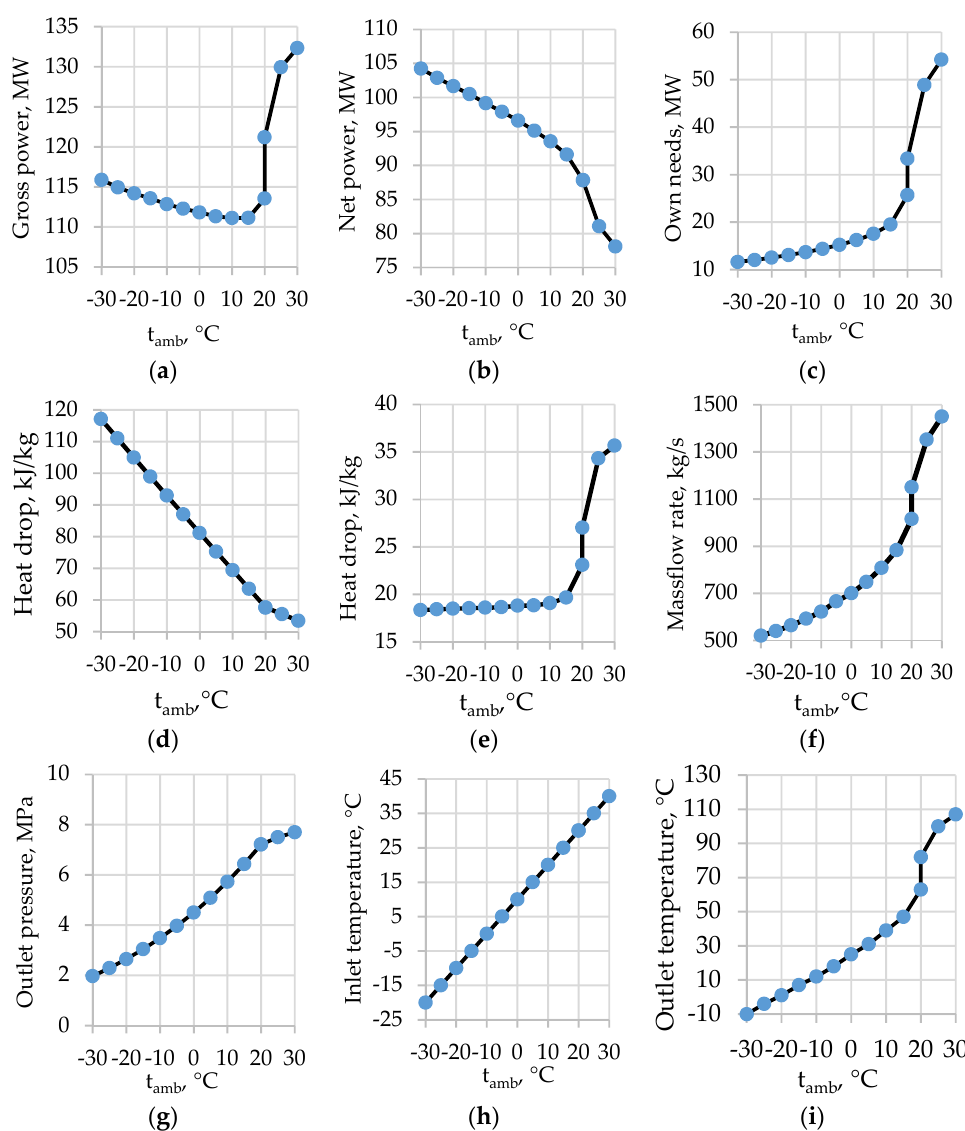
Figure 4. Ambient temperature influence on the performance of modified TPPs with BPSTs (Case 2b): ( a ) gross power, ( b ) net power, ( c ) own needs, ( d ) CO 2 turbine heat drop, ( e ) CO 2 pump/compressor heat drop, ( f ) mass flow rate, ( g ) CO 2 turbine outlet pressure, ( h ) CO 2 pump/compressor inlet temperature, and ( i ) CO 2 pump/compressor outlet temperature.